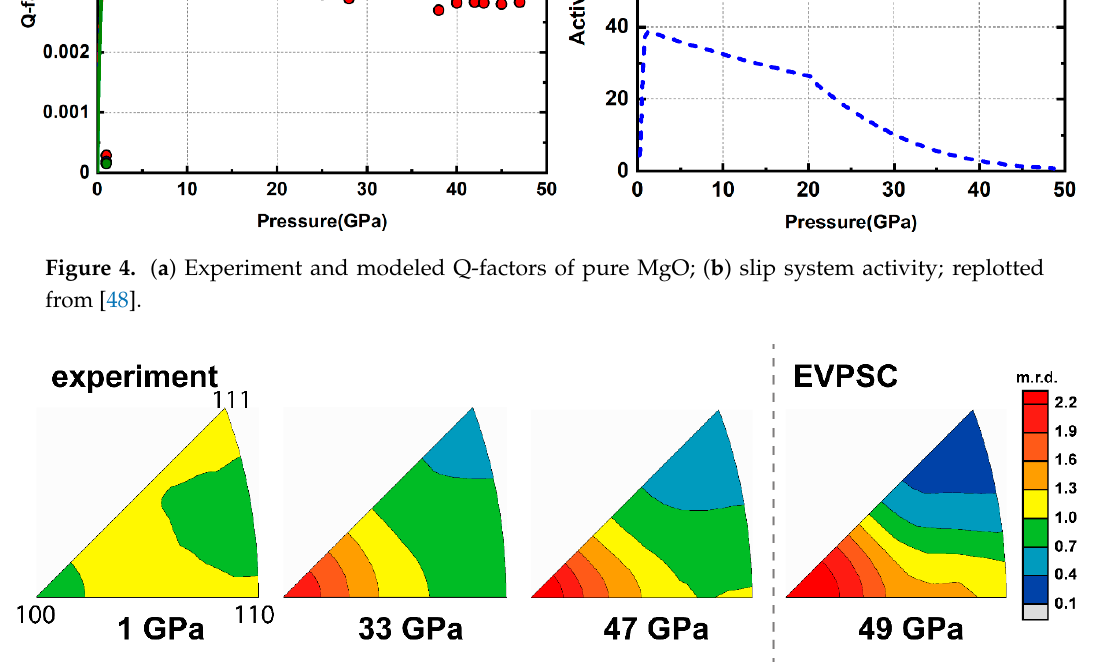
Figure 5. IPFs of experimental and modeled textures of pure MgO; replotted from [48]. Scale bar is given in multiples of random distribution (m.r.d.)